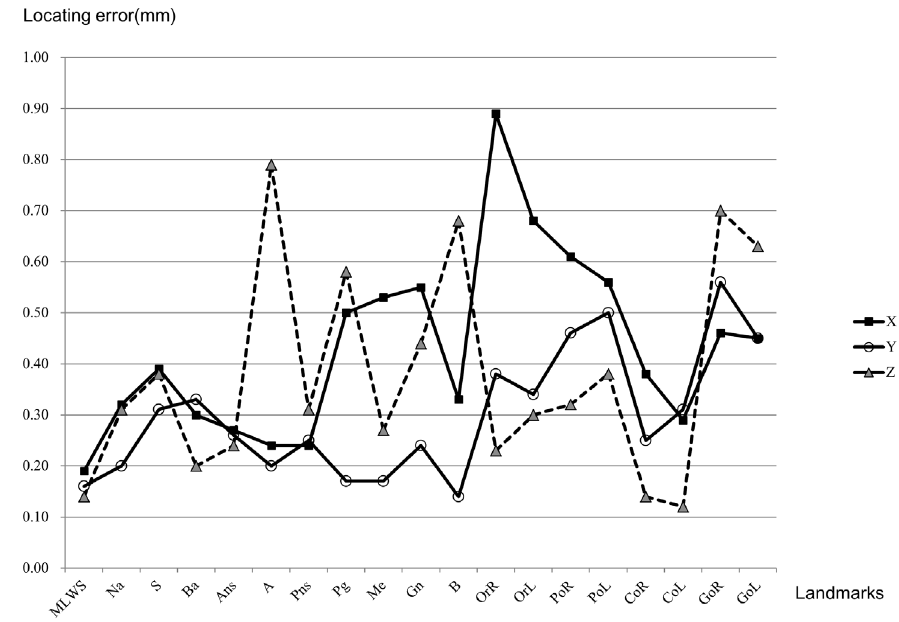
Figure 5. Locating error (coordinate).